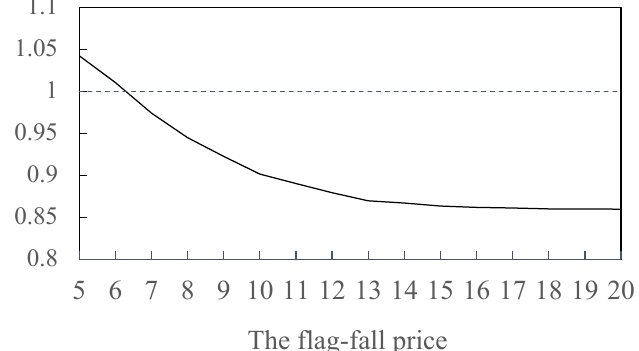
Figure 6. Ratio of maximum social welfare in case 1 to that in case 2 versus the flag–fall price of taxis.